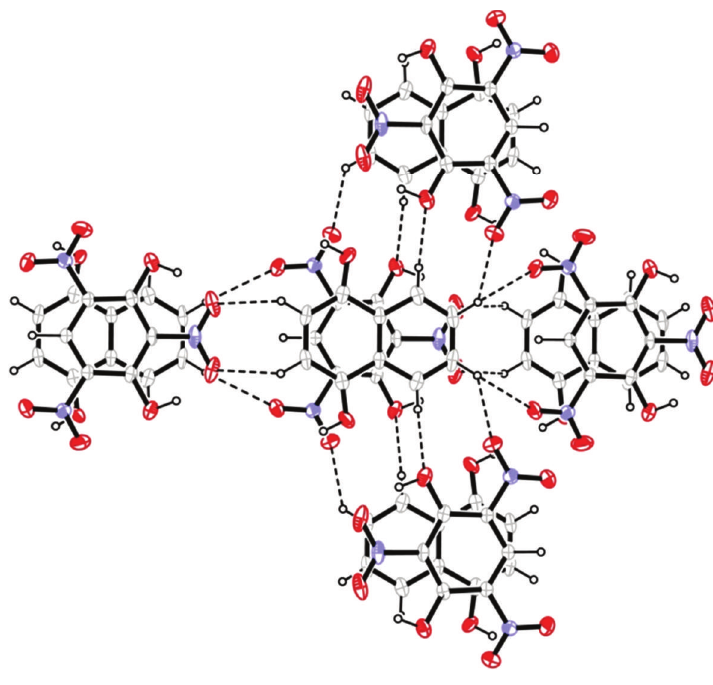
Figure 7: The arrangement of polymeric chains along 𝑎 and 𝑏 axis.